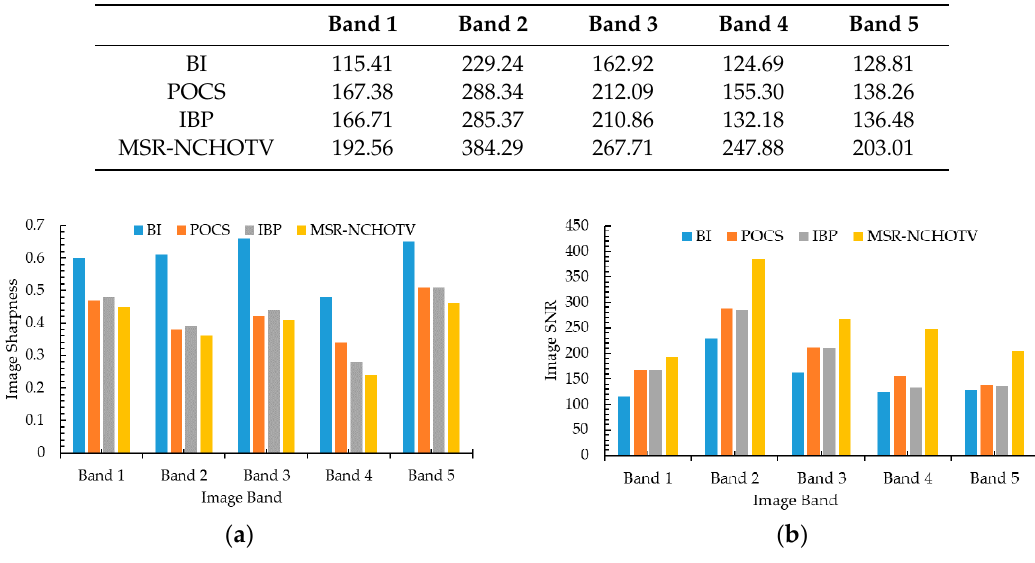
Figure 5. Image sharpness ( a ) and SNR ( b ) for Experiment 1.